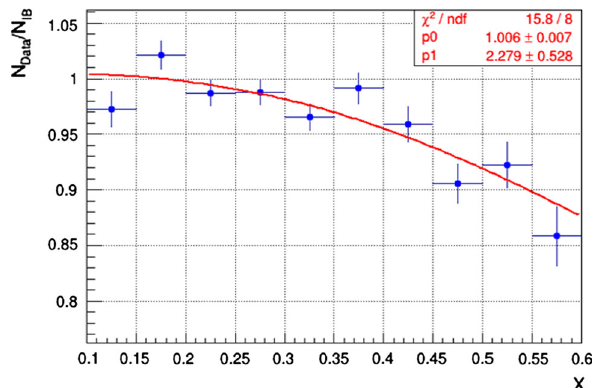
Fig. 7 χ PT O ( p 6 ) fit, F V ( 0 ) and F A are taken from theory. The fit gives λ = 2 . 279 ± 0 . 528